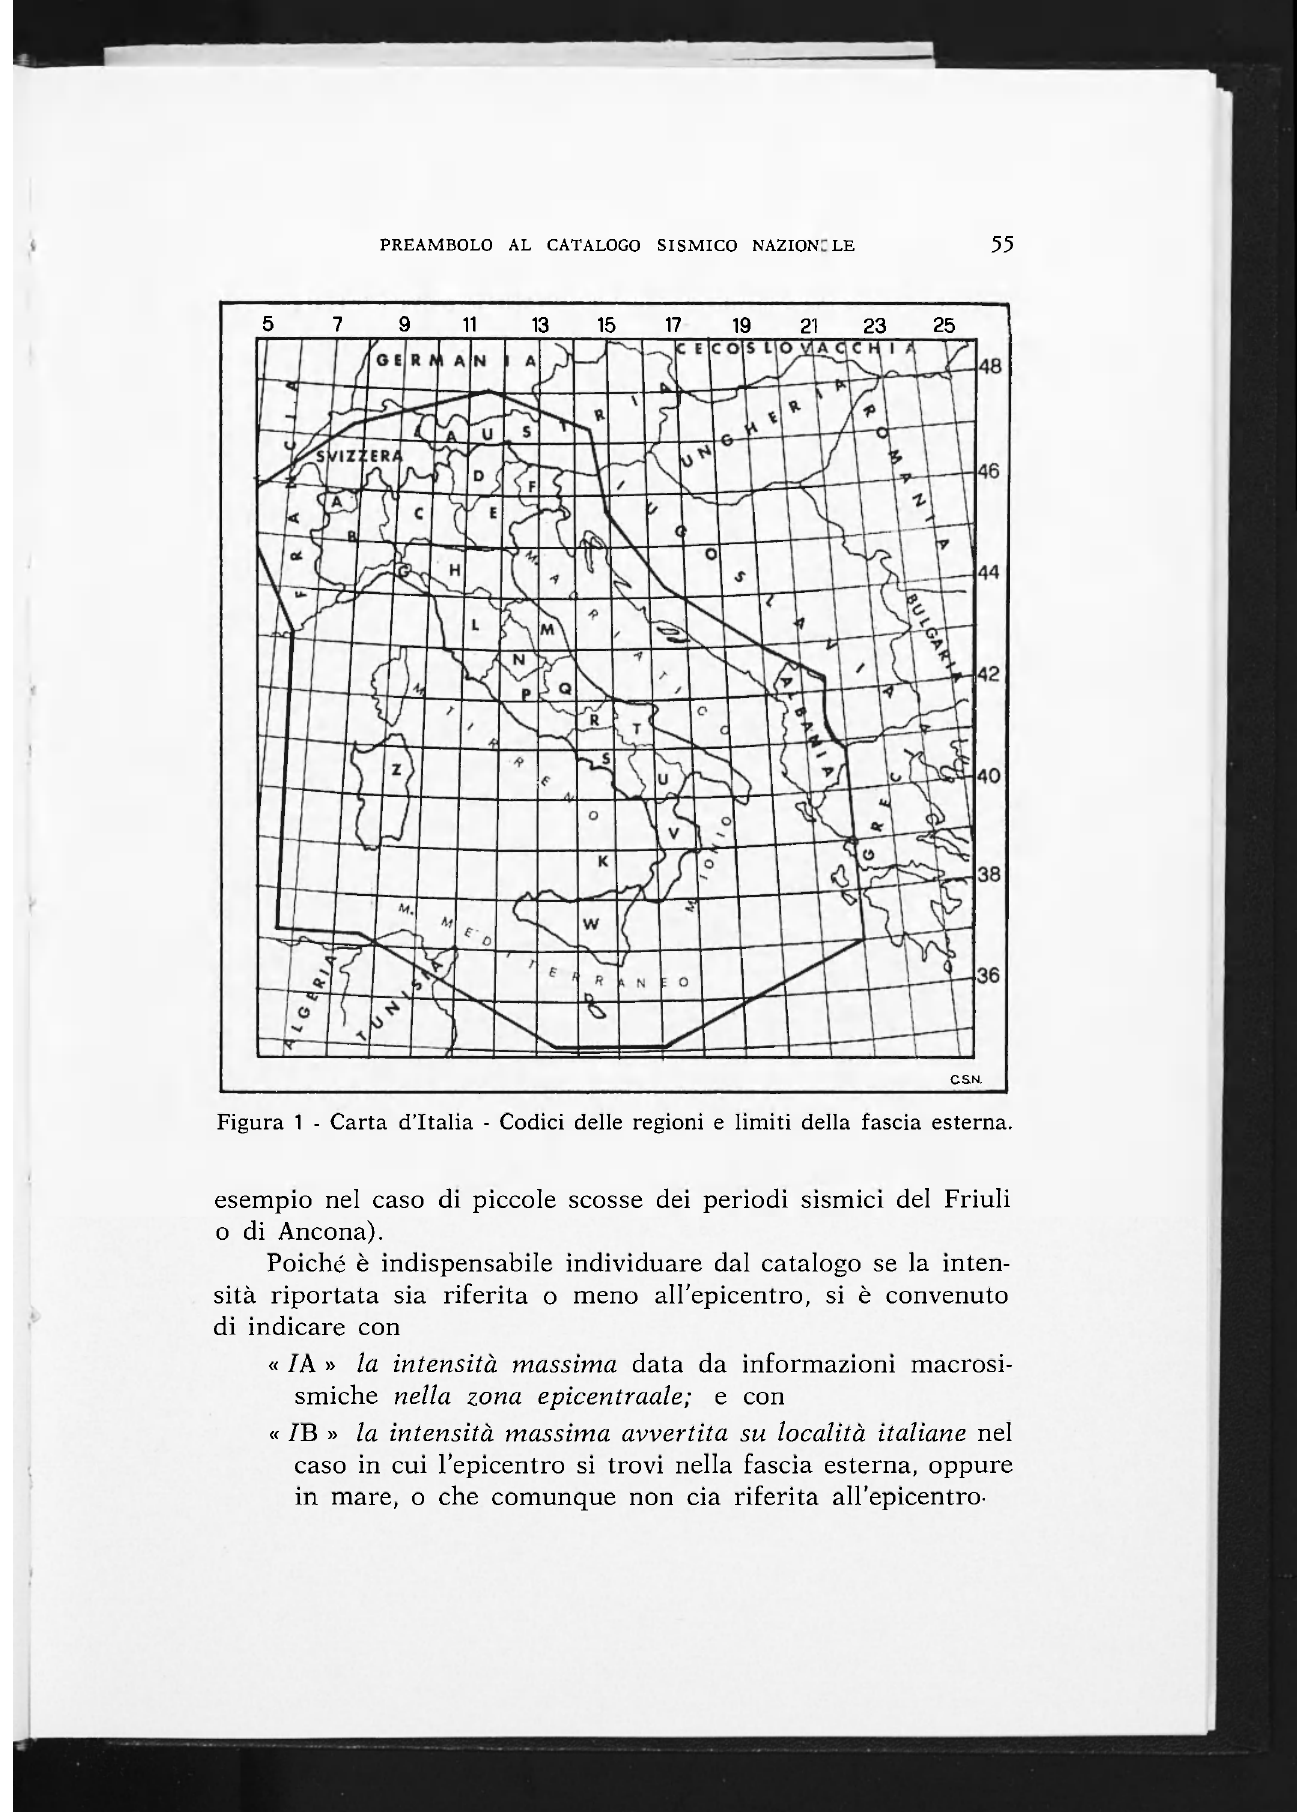
Figura 1 - Carta d'Italia - Codici delle regioni e limiti della fascia esterna. esempio nel caso di piccole scosse dei periodi sismici del Friuli o di